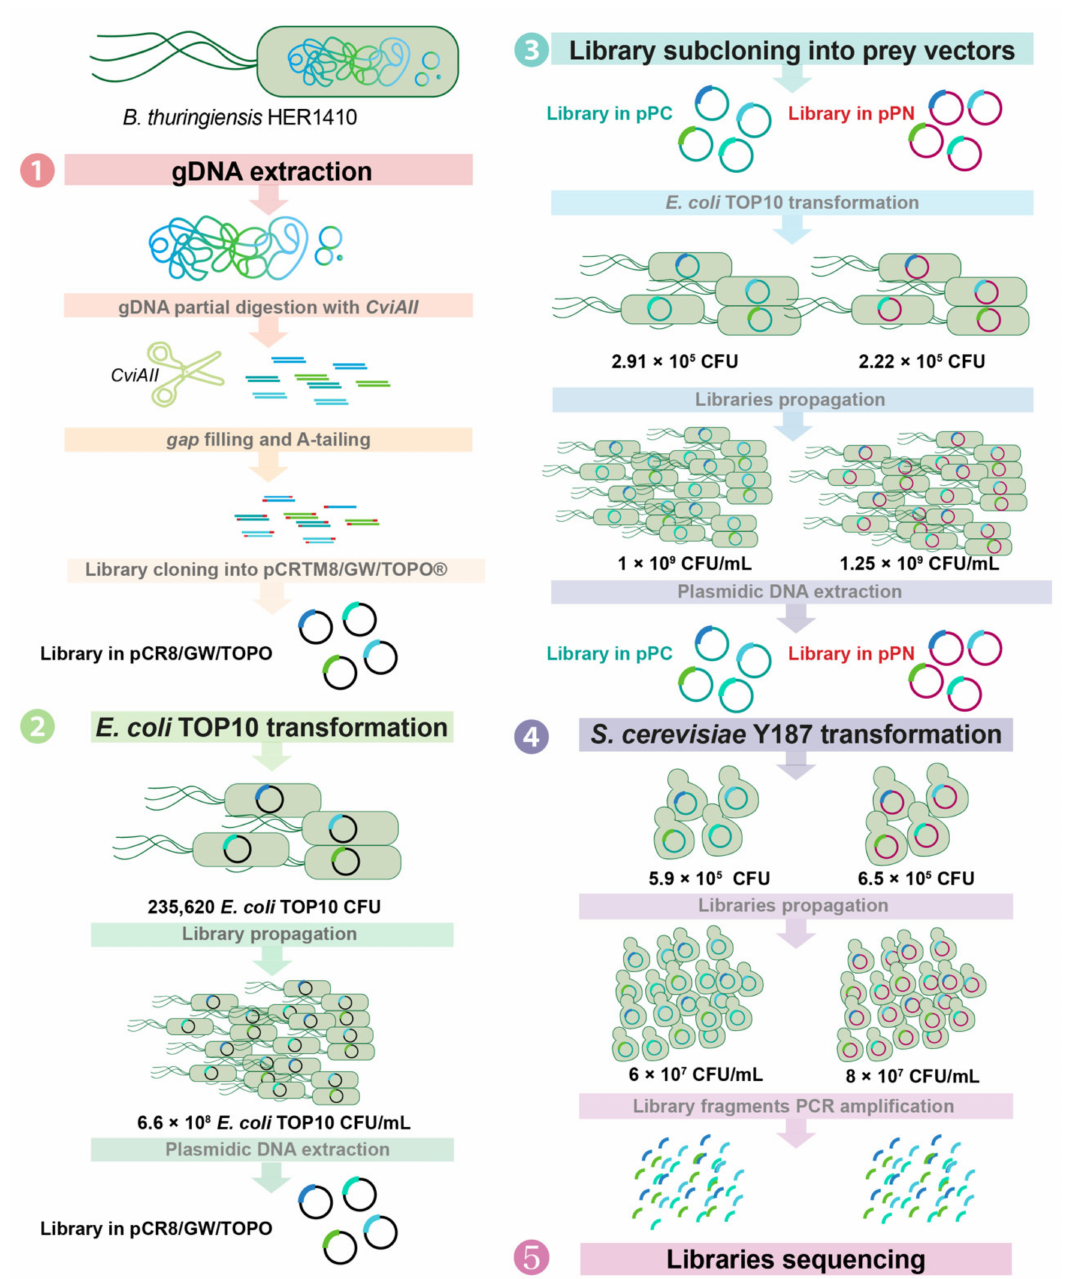
Figure 1. Y2H genomic library construction workflow. ( 1 ) The genomic DNA of B. thuringiensis HER1410 (blue-green) was partially digested using CviAII and cloned into the pCRTM8/GW/TOPO vector (black circles), generating the HER1410 genomic library in pCRTM8/GW/TOPO. ( 2 ) This library was used to transform Escherichia coli TOP10 cells that were propagated and used for plasmid extraction. ( 3 ) The library in pCRTM8/GW/TOPO was subcloned into the Y2H prey vectors pPC (teal circles, DNA-binding Gal4p activation domain (AD) fused at the C-terminus of the genomic fragment) and pPN (red circles, AD fused at the N-terminus), generating genomic libraries in pPC and pPN. After the transformation, propagation, and plasmid DNA extraction, both libraries were used to transform S. cerevisiae Y187 ( 4 ). Libraries in S. cerevisiae were propagated, plasmid-extracted, PCR-amplified, and sequenced using Illumina HTS ( 5 , see below and Figure 2). The number of independent clones for each transformation step is